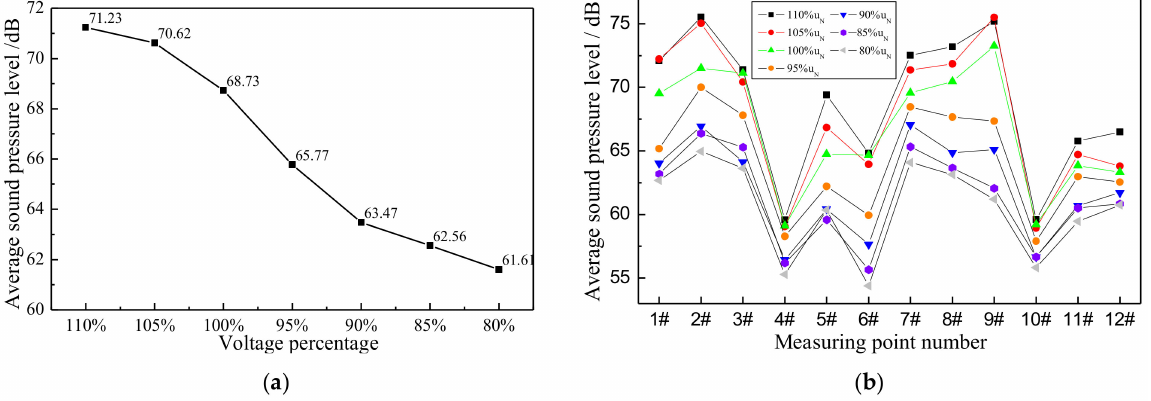
Figure 10. Sound pressure levels around the transformer. ( a ) ASPLs at different U N levels; ( b ) SPL of each measurement point.